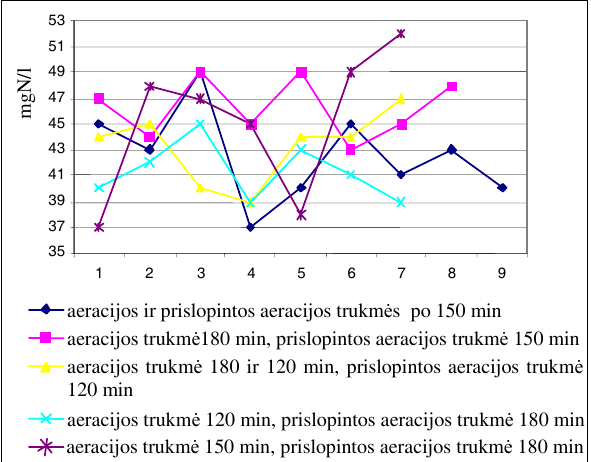
Fig 2. Total nitrogen concentration in wastewater after mechanical treatment during five